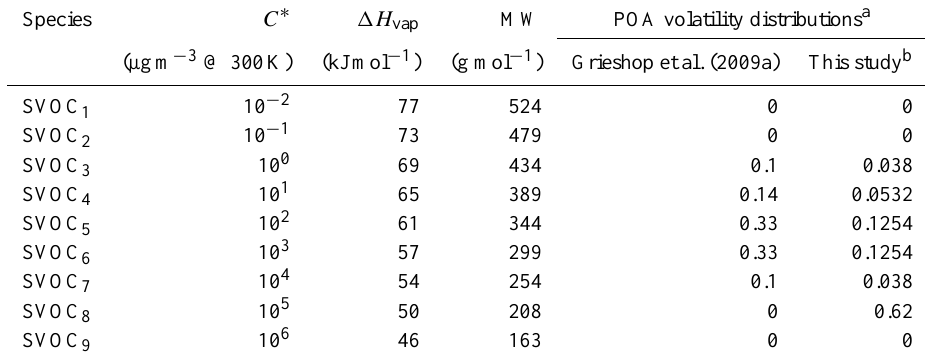
Table 1. Definition of SVOC species following Grieshop et al. (2009a). Species